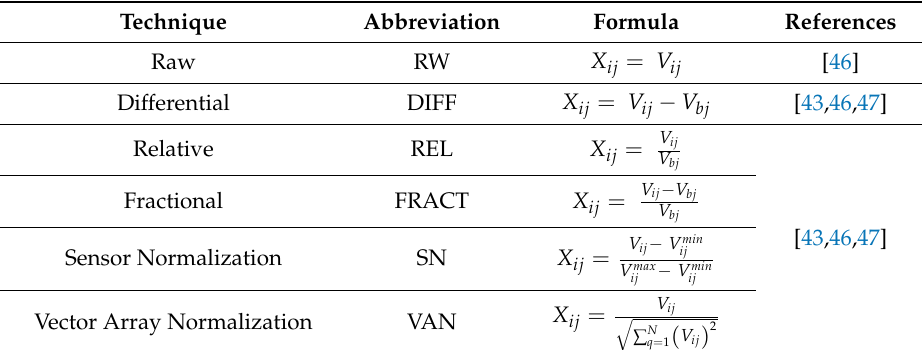
Table 5. Data pre-processing techniques selected.